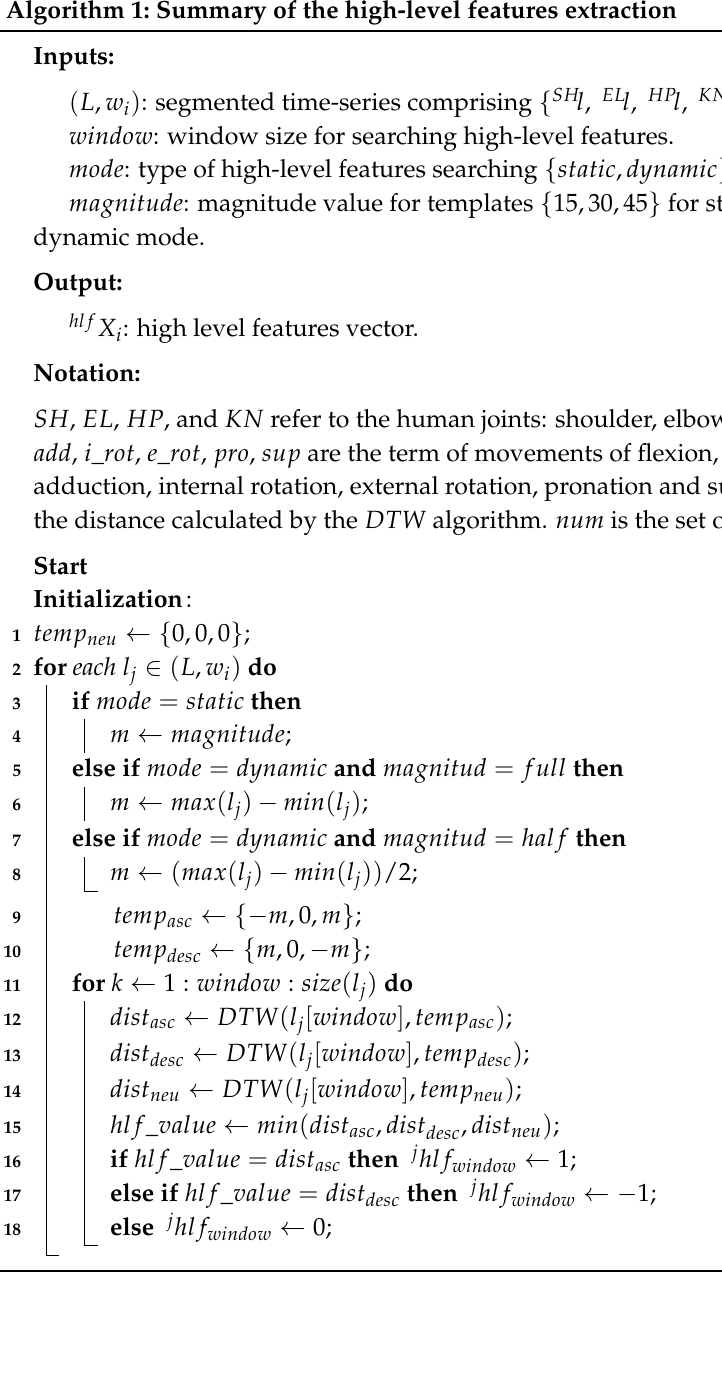
Algorithm 1: Summary of the high-level features